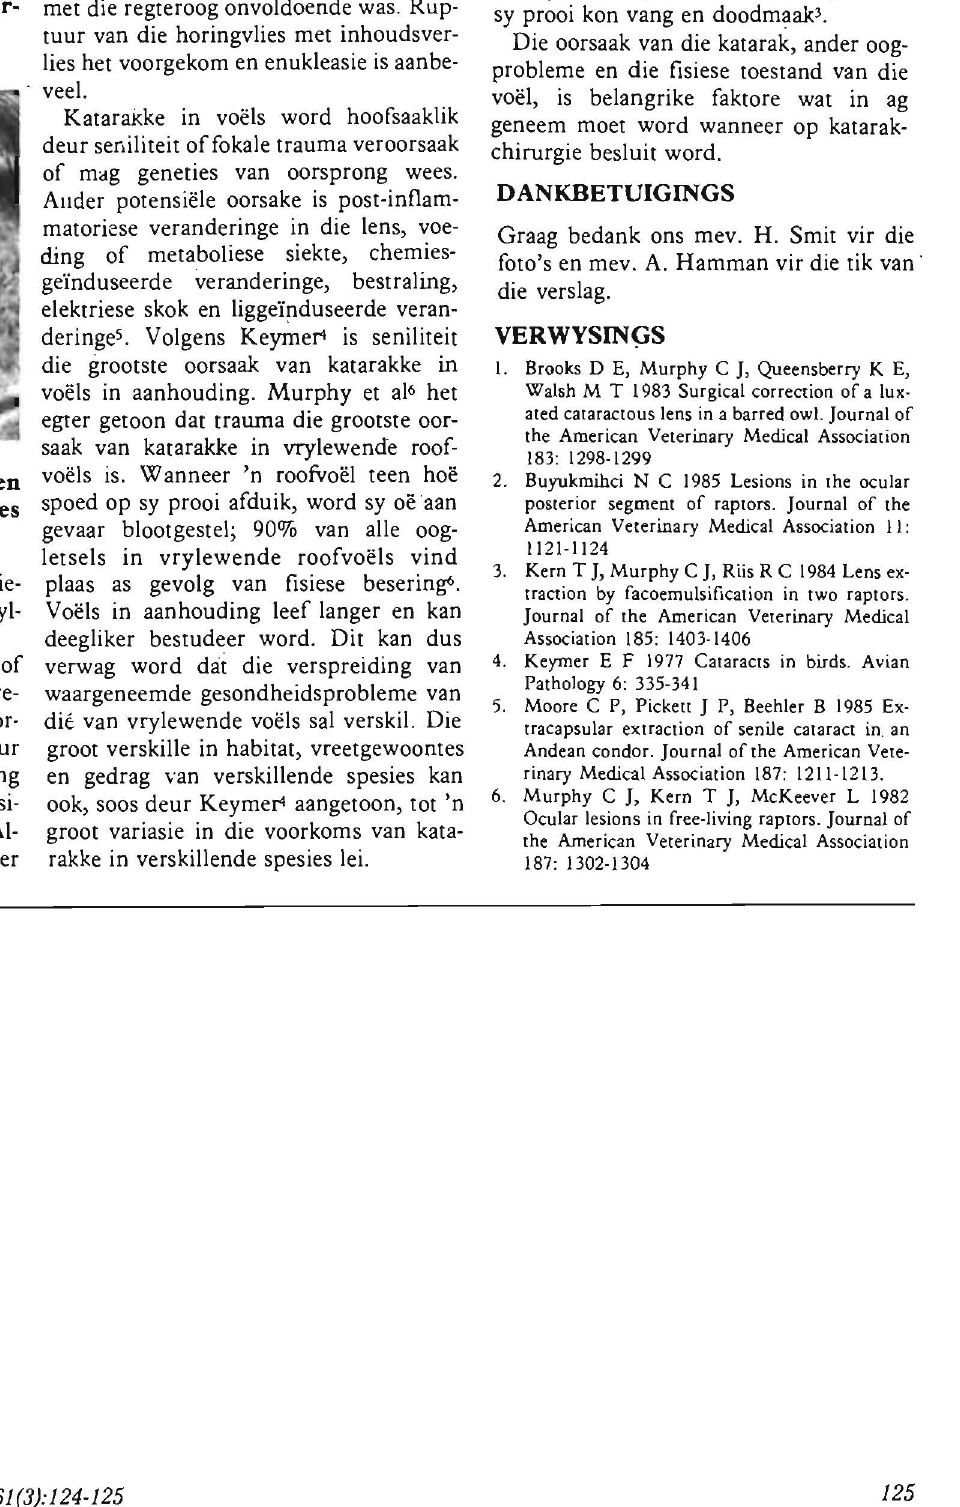
Fig. 2: Die kop van die blouvalkie om die miose van die regter oog te toon